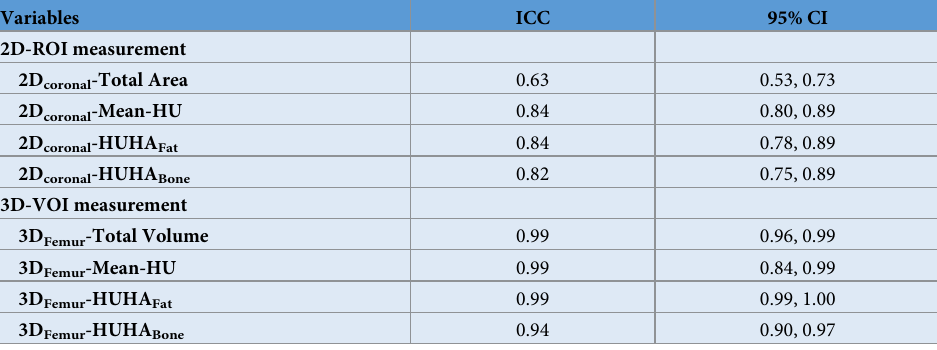
CI = confidence interval; HUHA = HU histogram analysis; ICC = Intraclass Correlation